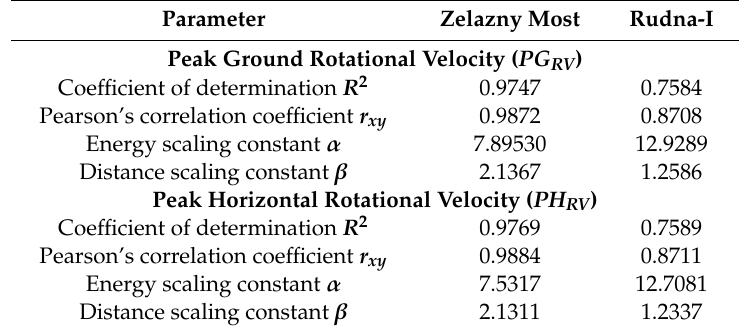
Table 3. Coefficients of correlation and empirical parameters for rotation prediction formulas.